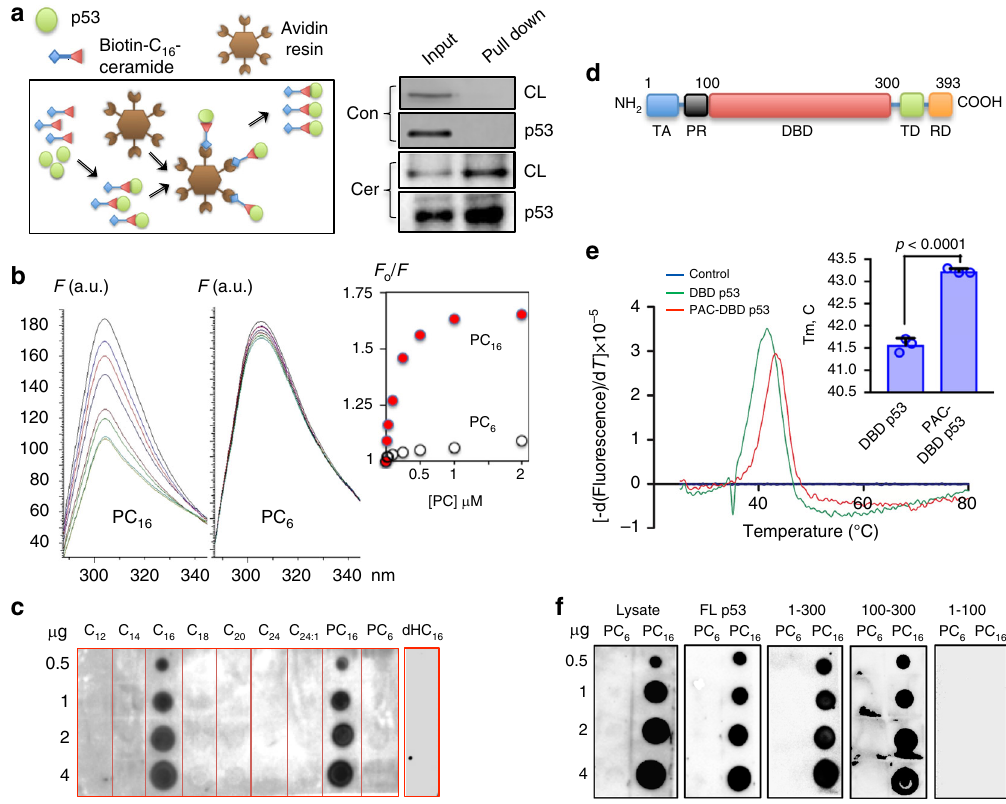
Fig. 2 p53 binds C 16 -ceramide within the core domain. a Left panel, schematic depicting p53 pull down on biotinylated ceramide. Right panel, pulled down preparations (from A549 cells lysate, CL, or pure recombinant p53) analyzed by SDS-PAGE/western blot with p53-speci fi c antibody. For ceramide pull down (Cer), puri fi ed p53 or A549 cell lysates were incubated with biotinylated ceramide, while in control experiments (Con), both p53 and cell lysates were incubated with biotin. b Titration of p53 DBD (DNA-binding domain, the construct containing amino acid residues 100 – 300) tyrosine fl uorescence with PC 16 (left panel) or PC 6 (middle panel). Right panel, data plotted as a function of the ceramide concentration. F 0 and F are intrinsic p53 fl uorescence in the absence or presence of ceramide, respectively. c Binding of puri fi ed p53 to a panel of ceramides with different acyl chain length (C 12 – C 24 natural ceramides, dhC 16 natural C 16 - dihydroceramide, PC 6 and PC 16 pyridinium ceramides with C 6 and C 16 acyl chains, respectively) immobilized on a PVDF membrane. Amounts of compounds in respective spots are indicated; bound p53 was detected with speci fi c antibody. d Domain organization of p53 (TA